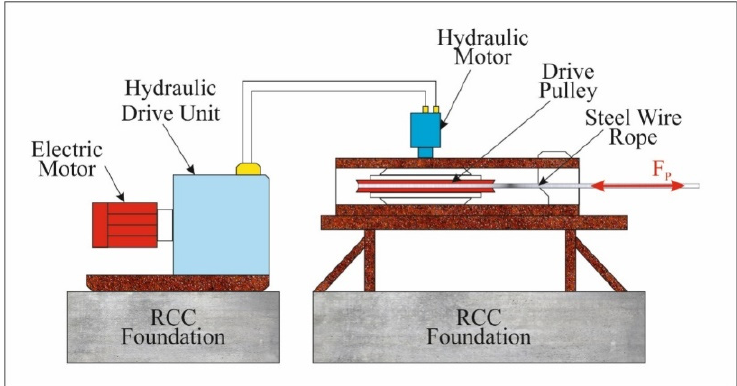
Figure 6. MRCL Drive Unit.